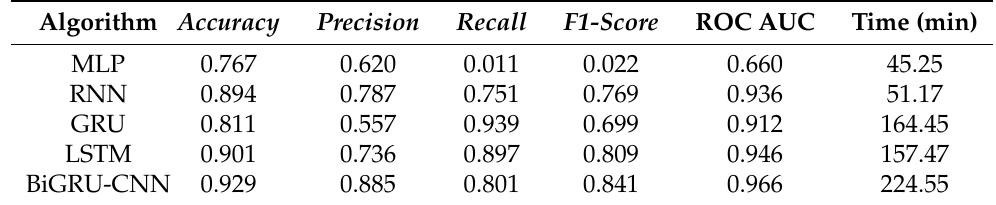
Table 1. Comparison of Metrics.